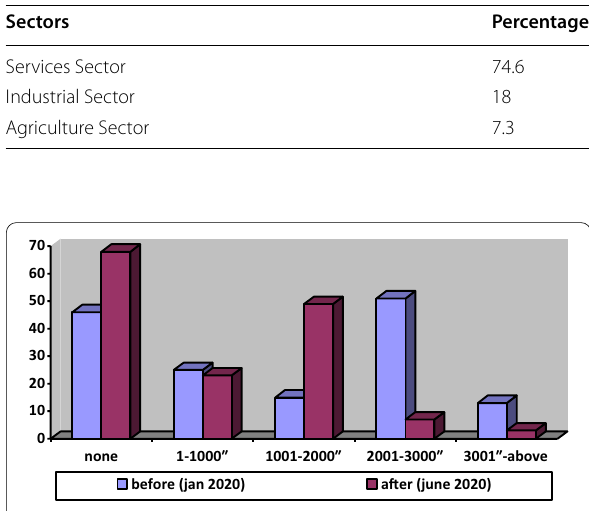
Fig. 5 Distribution by household income level